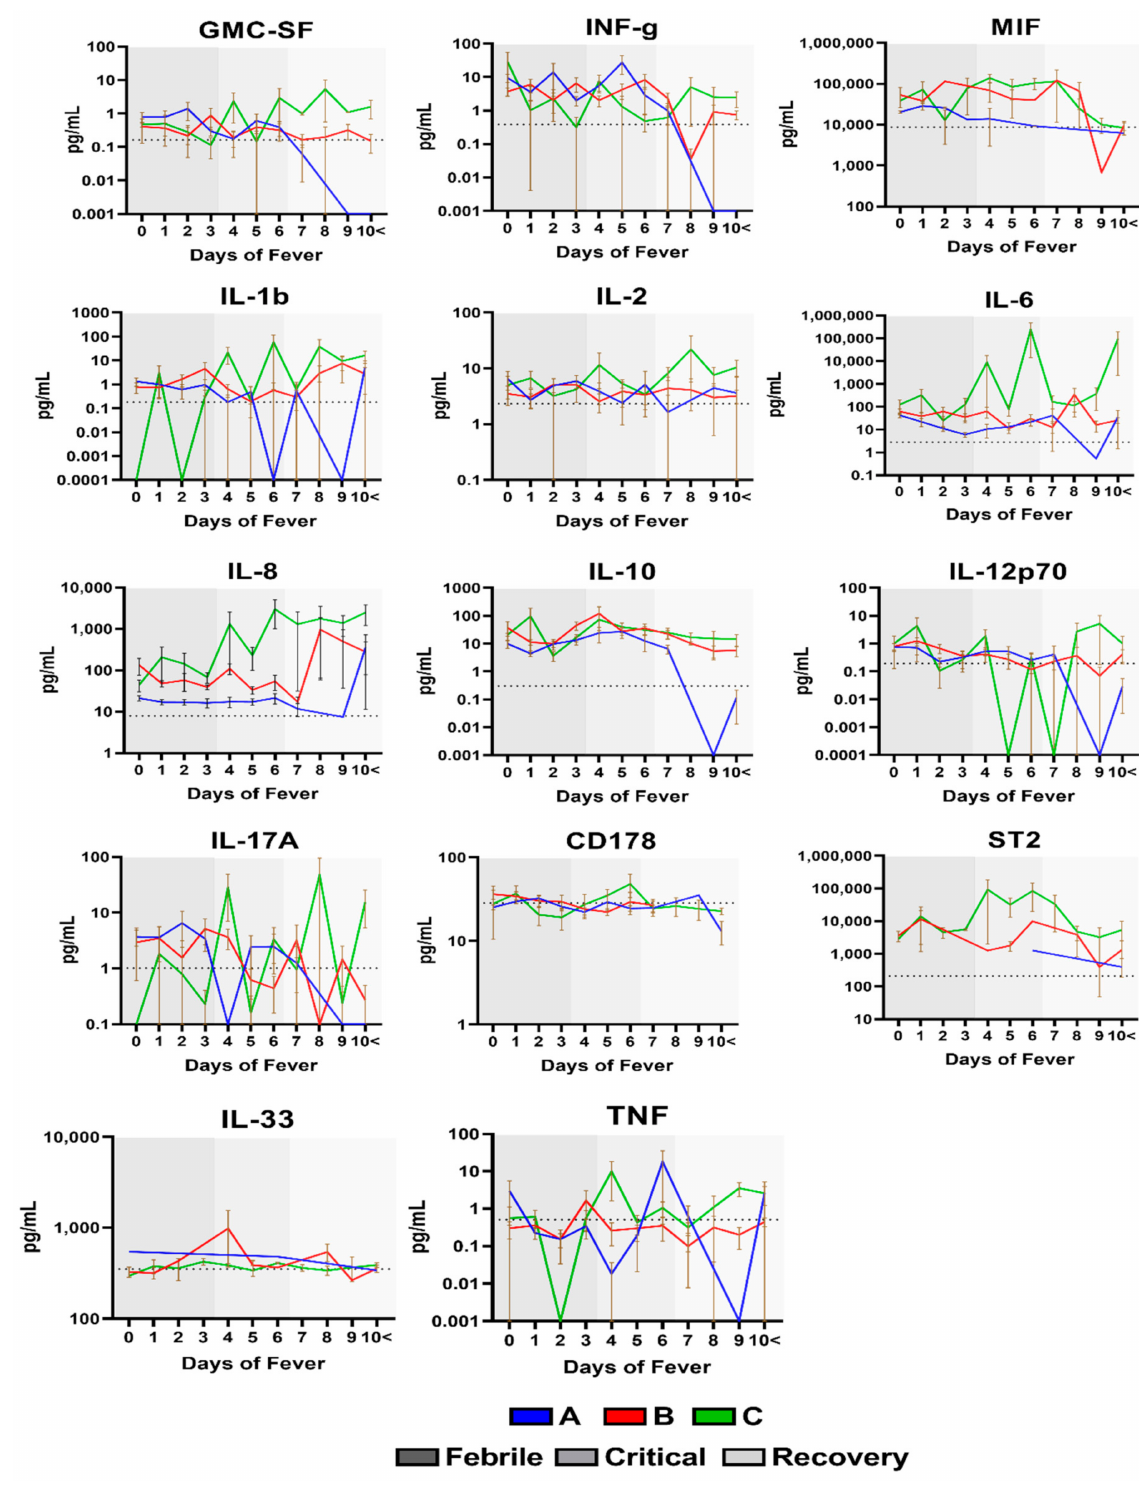
Figure 4. The level of Pro and Anti-Inflammatory molecules in dengue patients at different days of fever Graphs repre- senting the levels between the different groups of DENV patients previously divided following the 2009 WHO dengue classification scheme: dengue without warning sign symptoms (A), dengue with warning signs (B) and severe dengue (C). Colored shadings represent the different phases of dengue fever. Horizontal dotted line represents healthy mean average. Mean ±